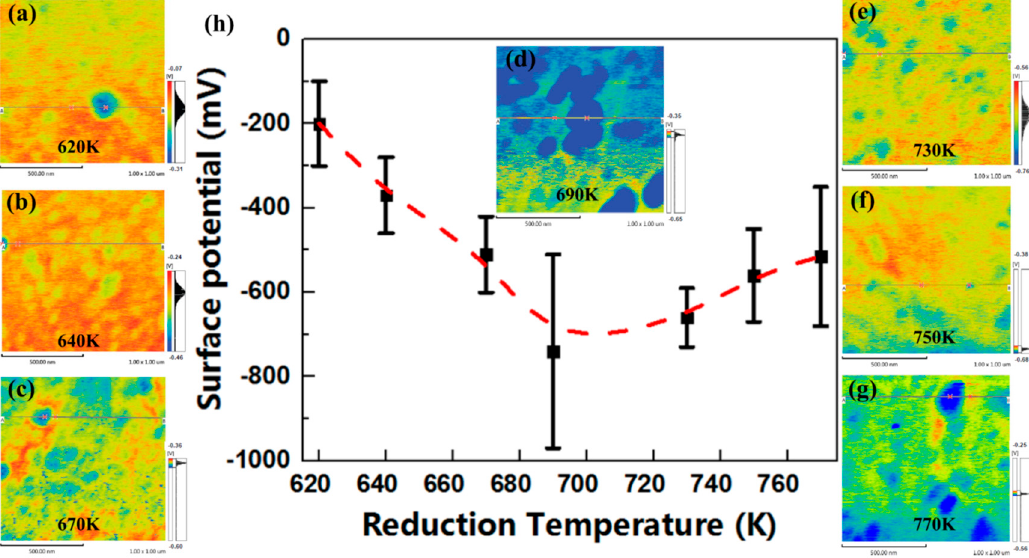
Figure 7. The surface topographies and extrema of CPD of reduced lead silicate glasses at the reduction temperatures from 620 K to 770 K ( a – h ).